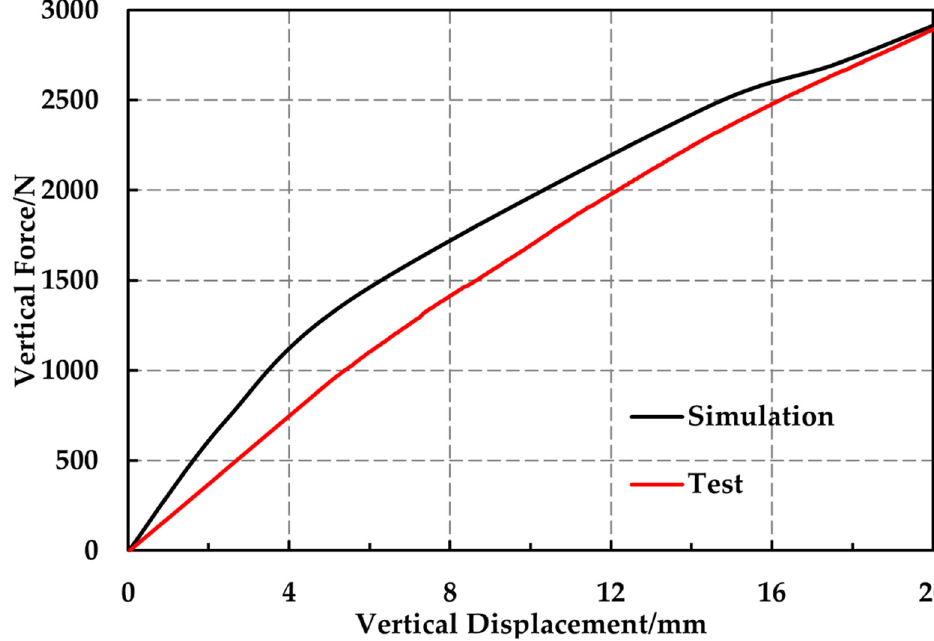
Figure 6. The courses of the center lines of the vertical stiffness in the test and simulation.